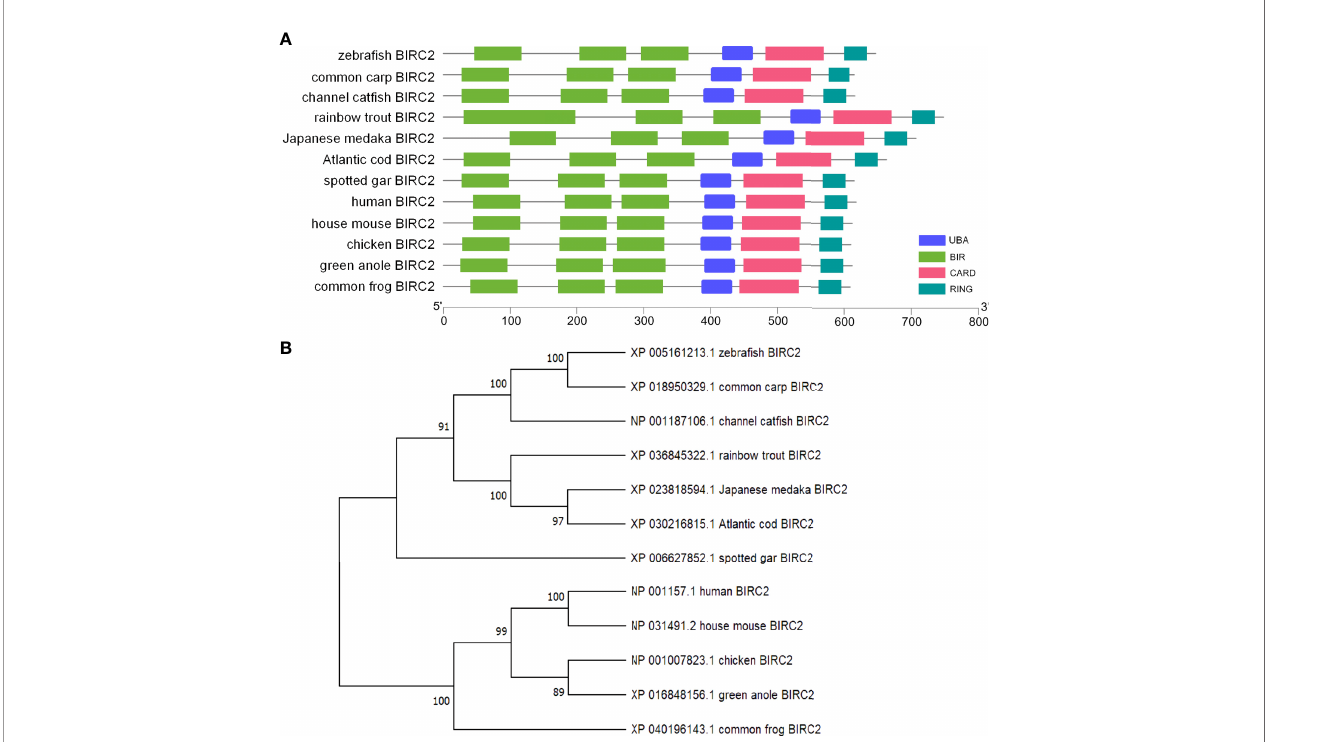
FIGURE 1 | Bioinformatics analysis of zebra fi sh BIRC2. (A) Schematic diagram of the modular domain architecture of vertebrate BIRC2. (B) Phylogenetic tree of vertebrate BIRC2. The amino acid sequences are aligned using CLUSTALW, and the tree is constructed by the N-J method supported with 10,000 bootstrap replications using MEGA X